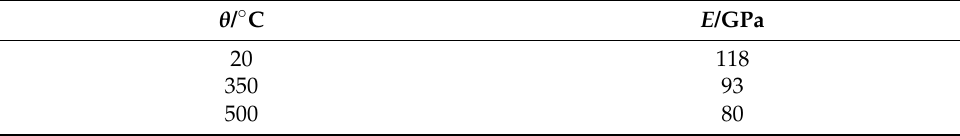
Table 1. The Young’s modulus of the beam (TA15).